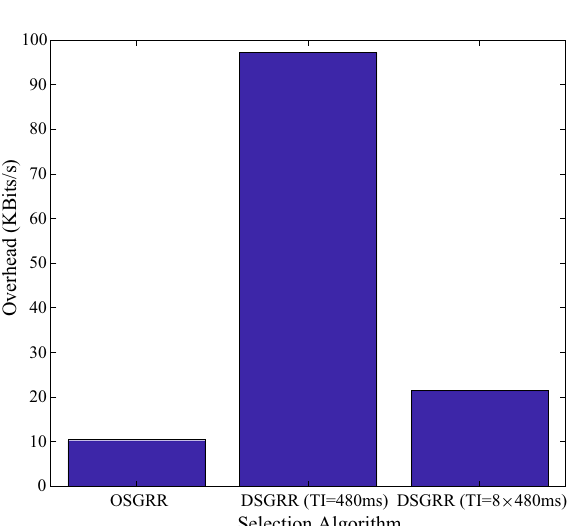
Fig. 14 Overhead comparison between open sub‑granting and dedicated sub‑granting algorithms. The impact of different position information and measurement transmission interval for the dedicated sub‑granting algorithm is